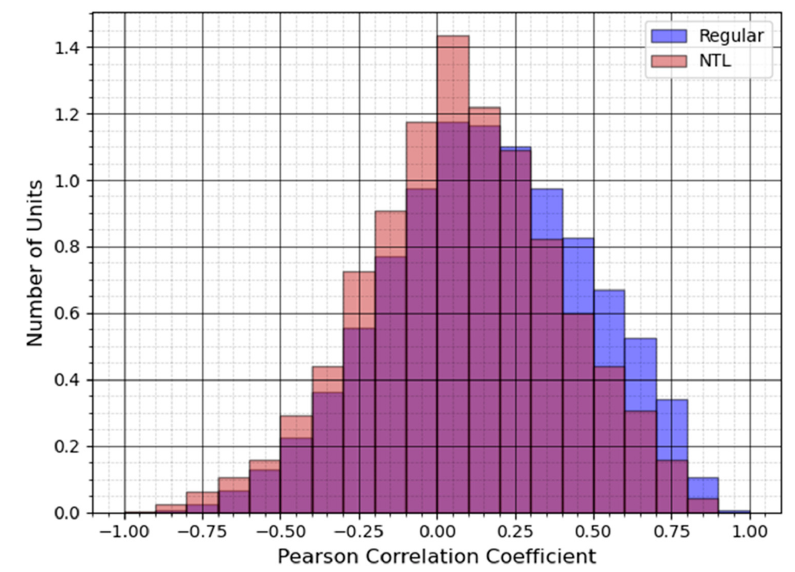
Figure 7. DB Pearson correlation distribution.